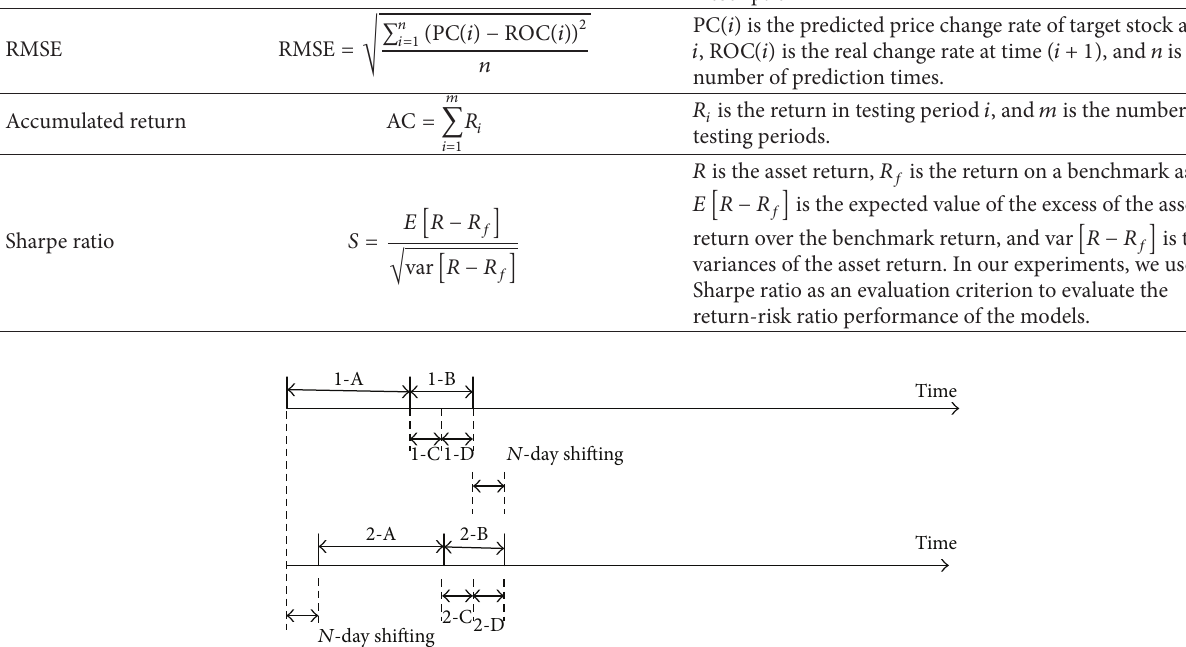
Figure 2: Rolling window method for training and forecasting (for example, 1-A means Period A (see Table 9) in 1st period).